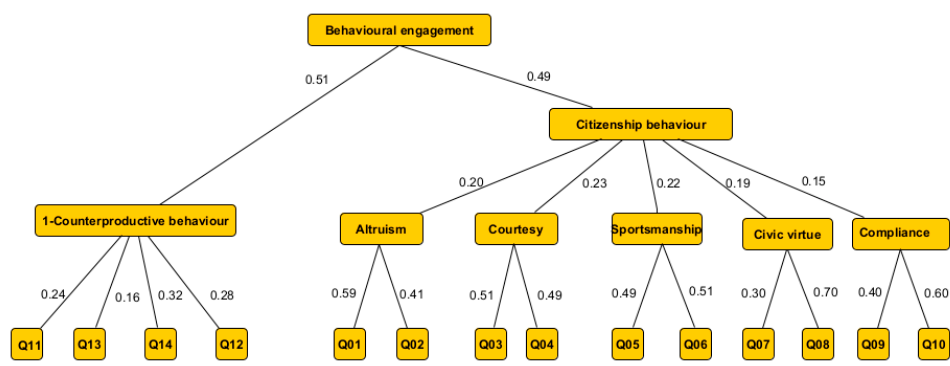
Figure 7. Fuzzy signature of the Lithuanian responses.